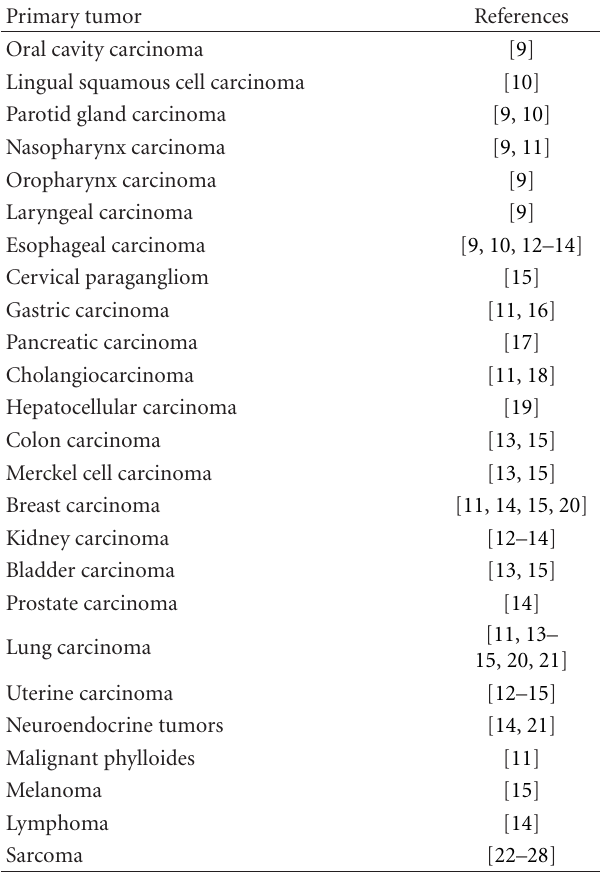
Table 1: Metastatic diseases of the thyroid gland. Primary